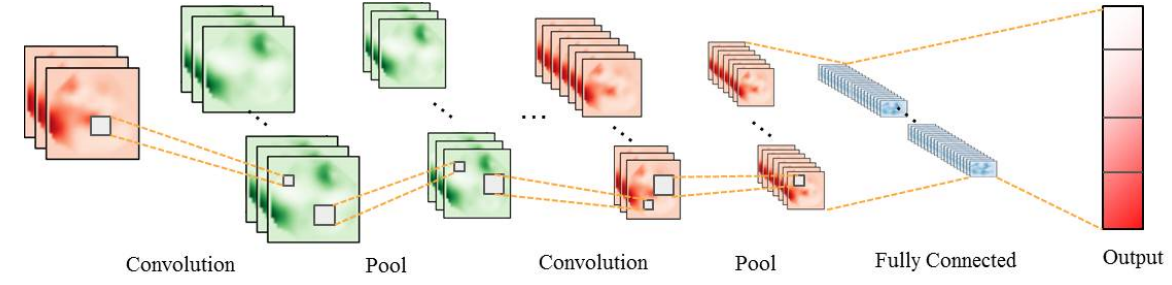
Figure 2. Structure of